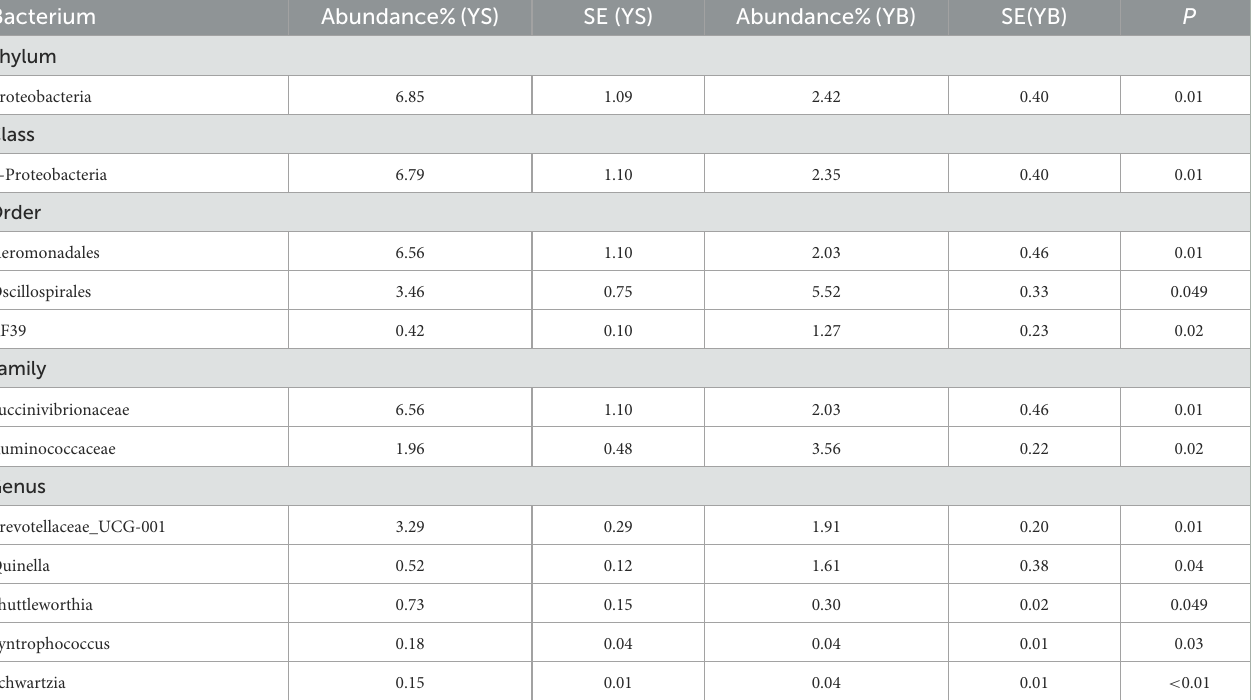
TABLE 6 The difference of rumen fluid at the bacterium (YS-YB).